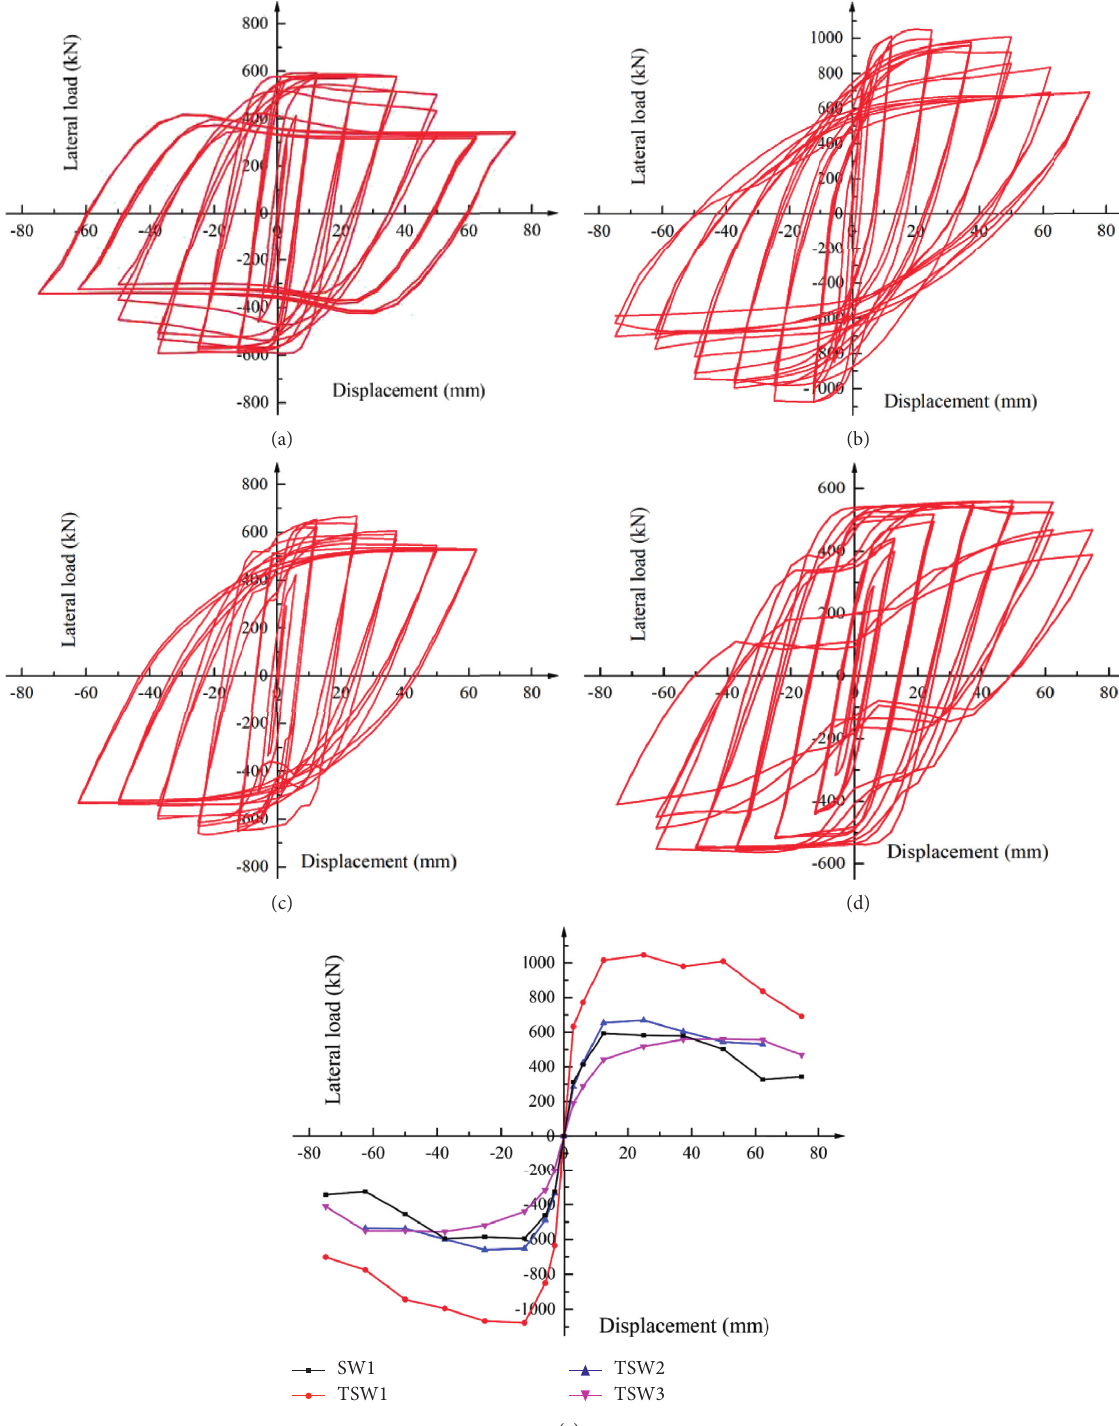
Figure 14: Hysteresis curves of four specimens: (a) SW1; (b) TSW1; (c) TSW2; (d) TSW3; (e) skeleton curves of four of the specimen. The potential reason for this is that the vertical distributed connecting bars in the groove are dis- connected, so all bending moments are transferred to the boundary confinement columns. Thus, the effect of separating the bending moment and the shearing forces is realized.